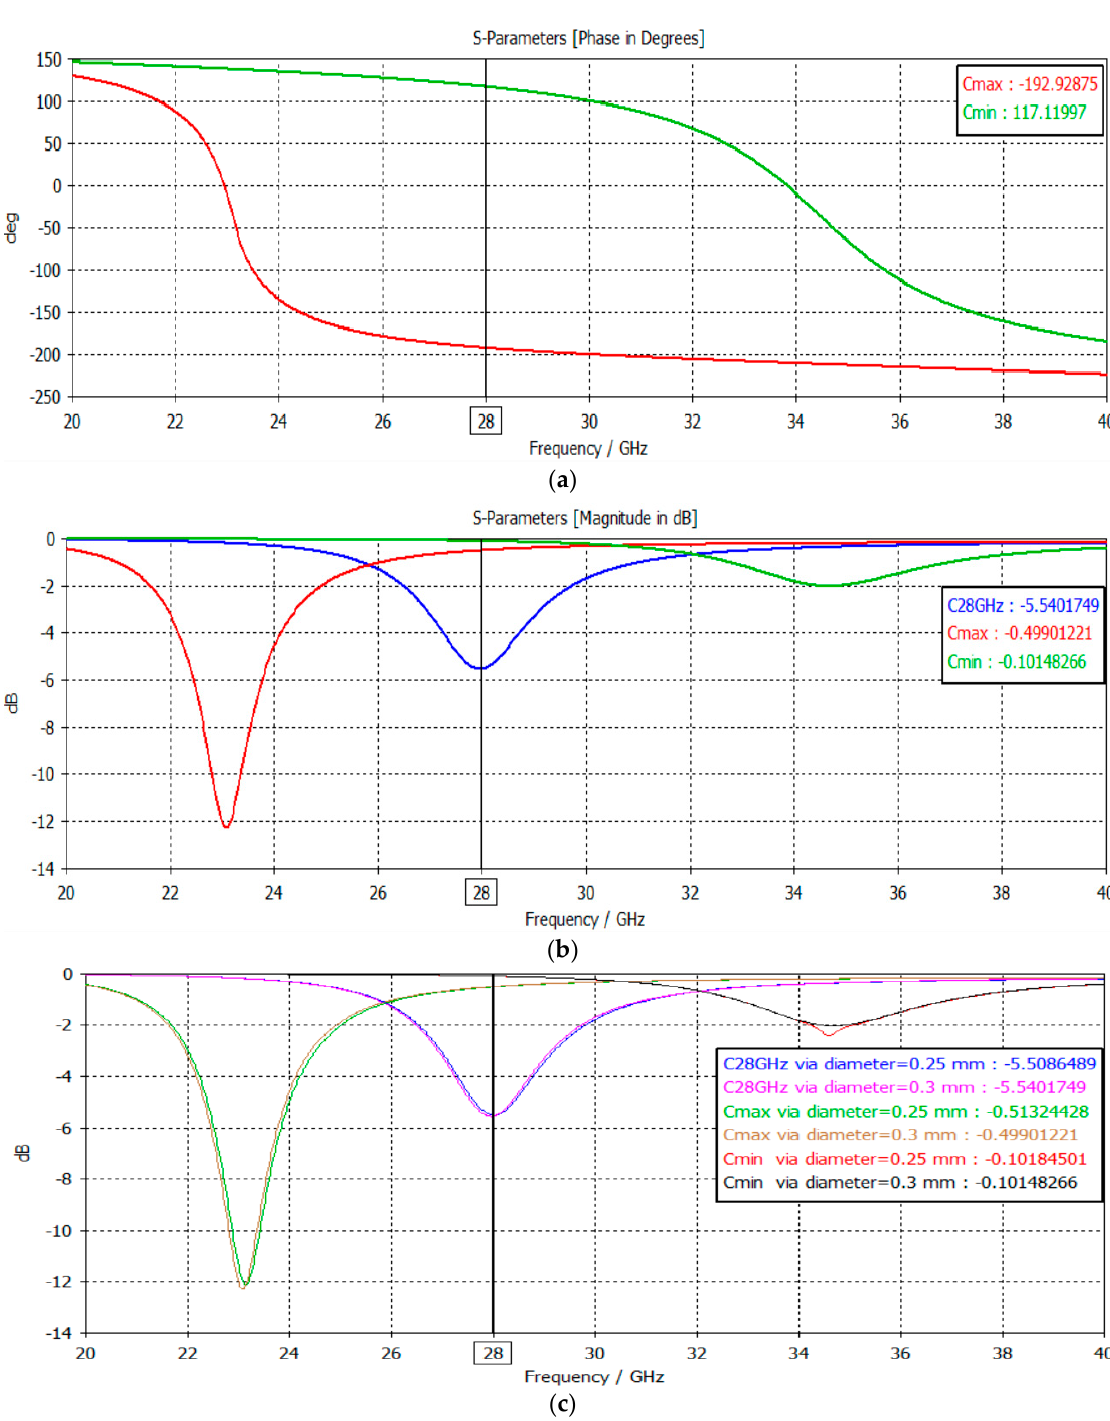
Figure 3. Simulation results of uniform unit cell reflection. ( a ) Phase. ( b ) Magnitude. ( c ) Influence of the via diameter. The simulation results of type A and type B unit cell phase reflection and magnitude